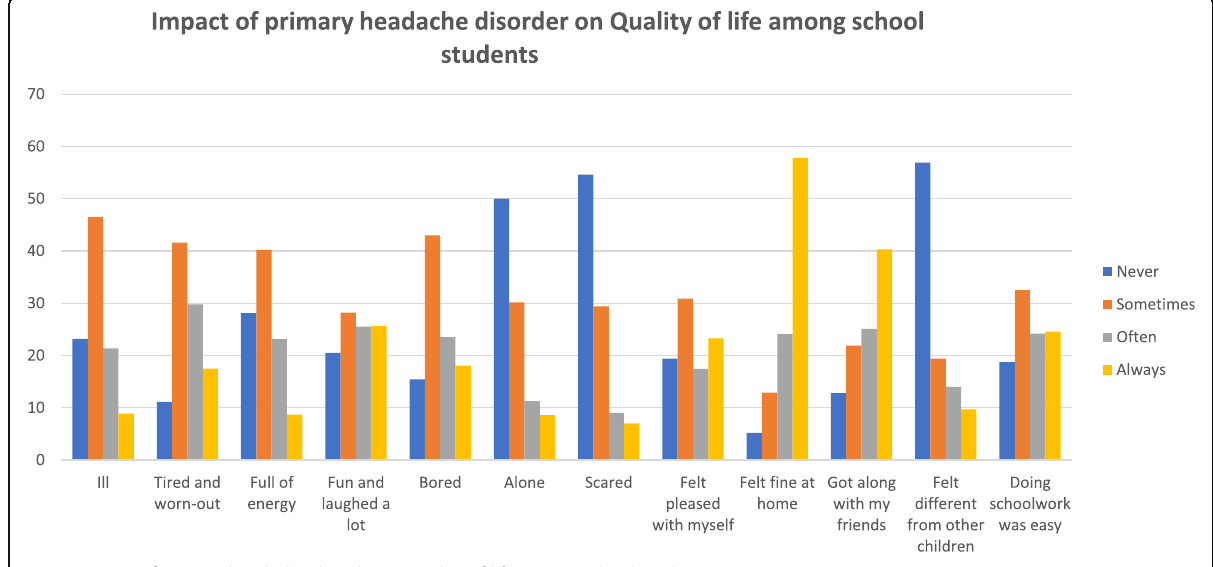
Fig. 2 Impact of primary headache disorder on quality of life among school